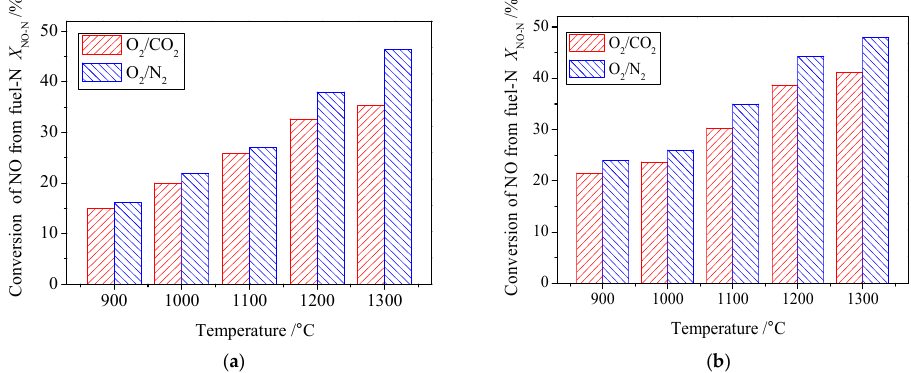
Figure 4. The oxidation of different nitrogen functional groups with a combustion atmosphere (21% O 2 ). ( a ) Synthetic coal “M6”; ( b ) Synthetic coal “M5”.